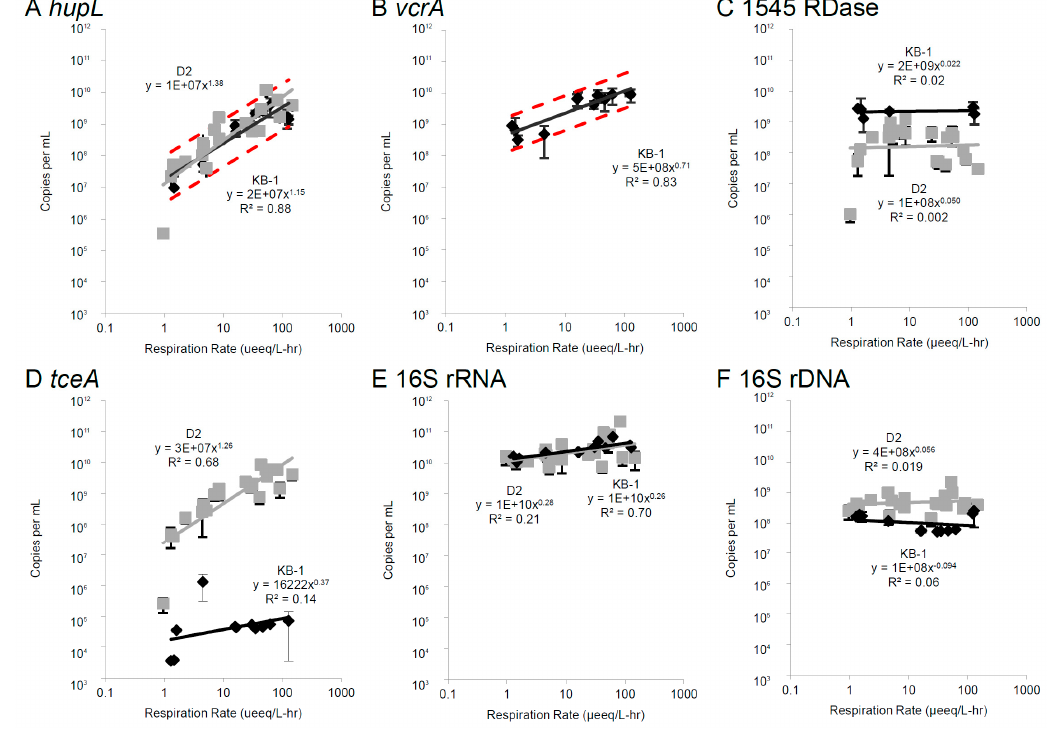
Figure 3. Pseudo-steady-state mRNA concentrations (copies per mL) of specific targets: hydrogenase hupL ( A ); reductive dehalogenases vcrA ( B ), 1545 ( C ), and tceA ( D ); and 16S rRNA units ( E ) and 16S rRNA genes ( F ) vs. steady-state respiration rates ( µ eeq/L · h) for the KB-1 culture (black diamonds) and D2 culture (grey squares). Error bars represent standard deviations of PSS mRNA measurements over time (Y-error bars). Power law trend lines for KB-1 (solid black line) and D2 (solid grey line) and 95% confidence intervals around the KB-1 trend (dashed red line) are displayed where appropriate. Note that reductive dehalogenase vcrA is not present in the D2 DMC strain’s genome. Corresponding trends with bvcA and hupL degenerate primers are shown in Figure S2.